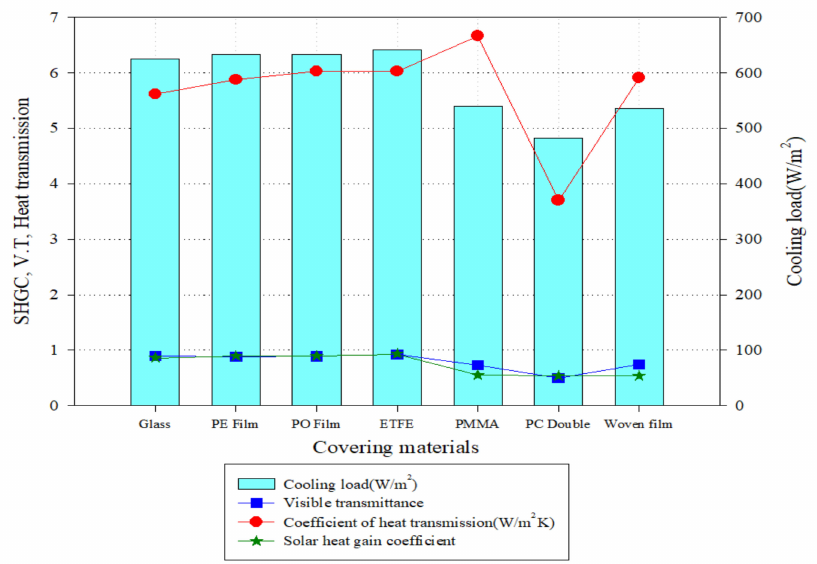
Figure 18. Cooling load, solar acquisition rate, visible light transmission rate, and heat transmission rate by cladding material.